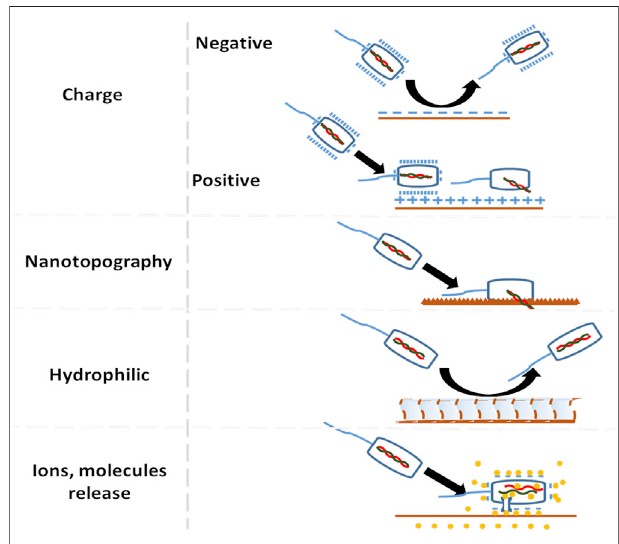
FIGURE3| Scaffoldsurface properties thatcanbe tunedtoincorporate anti-microbial properties.